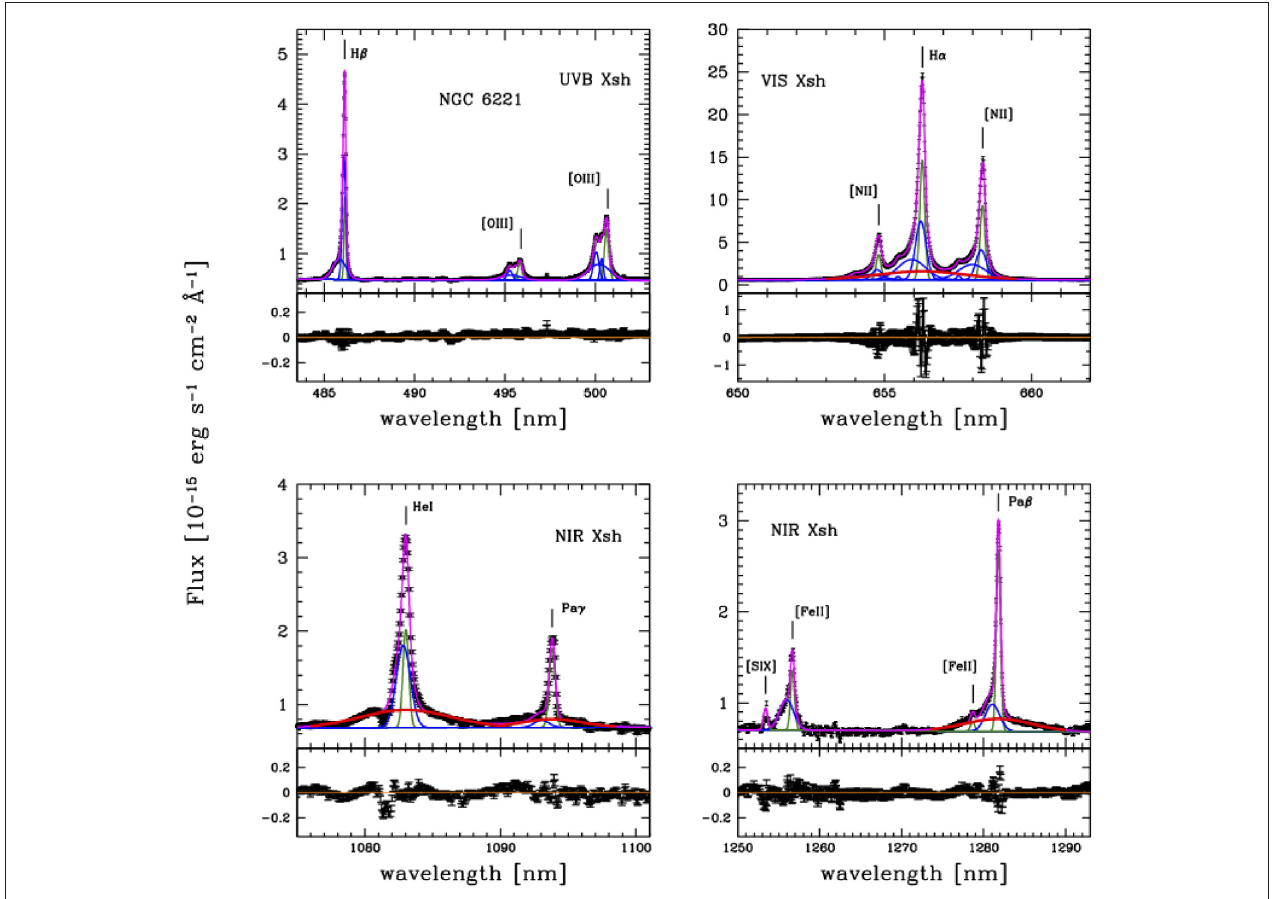
FIGURE 2 | Optical and NIR rest-frame spectra of NGC 6221. Top-left : H β +[OIII] region. Top-right : H α +[NII] region. Bottom-left : HeI+Pa γ region. Bottom-right : Pa β +[FeII] region. The narrow, intermediate, and broad components are shown with green, blue, and red lines, respectively. The magenta line shows the total fitting model. Vertical lines shows the wavelength of the emission lines. Bottom panels show the residuals of the fitting models.